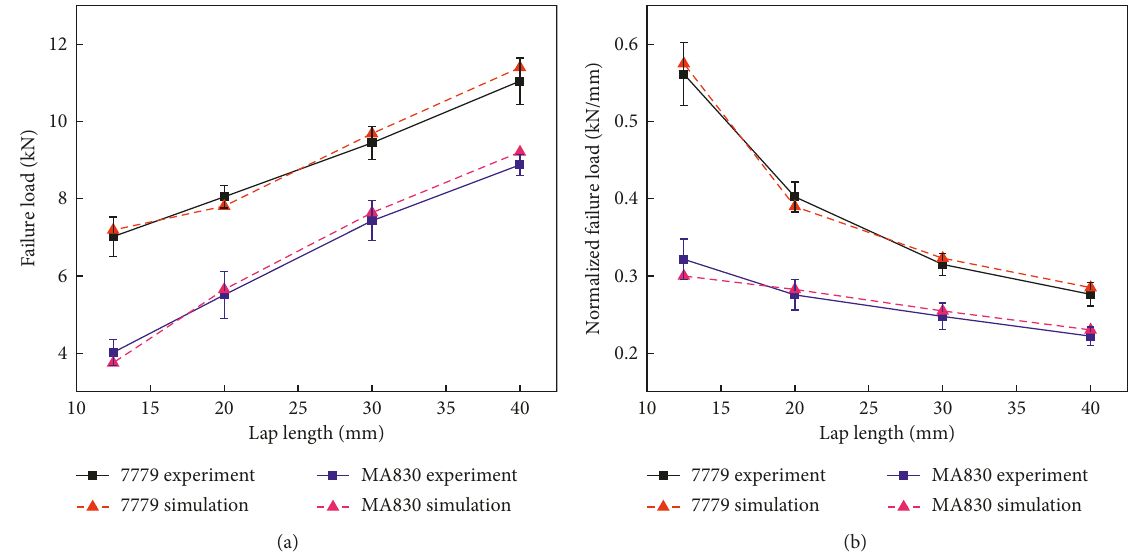
Figure 4: Experiment and simulation results: (a) failure load and (b) normalized failure load (failure load divided by overlap length).